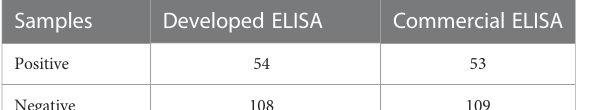
TABLE 4 Tests of clinical